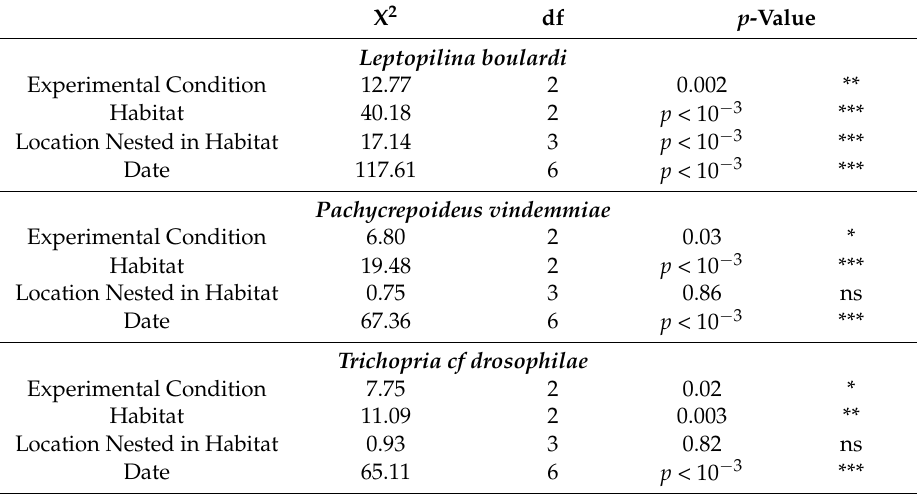
Table 3. Influence of experimental (Experimental Condition) and environmental (Habitat, Location, and Date) factors on the presence of three parasitoid species having emerged in Frozen Fruit traps. Levels of statistical significance: ns : not significant, * : 0.01 < p -Value ≤ 0.05; ** : 0.001 < p -Value ≤ 0.01; *** : p -Value ≤